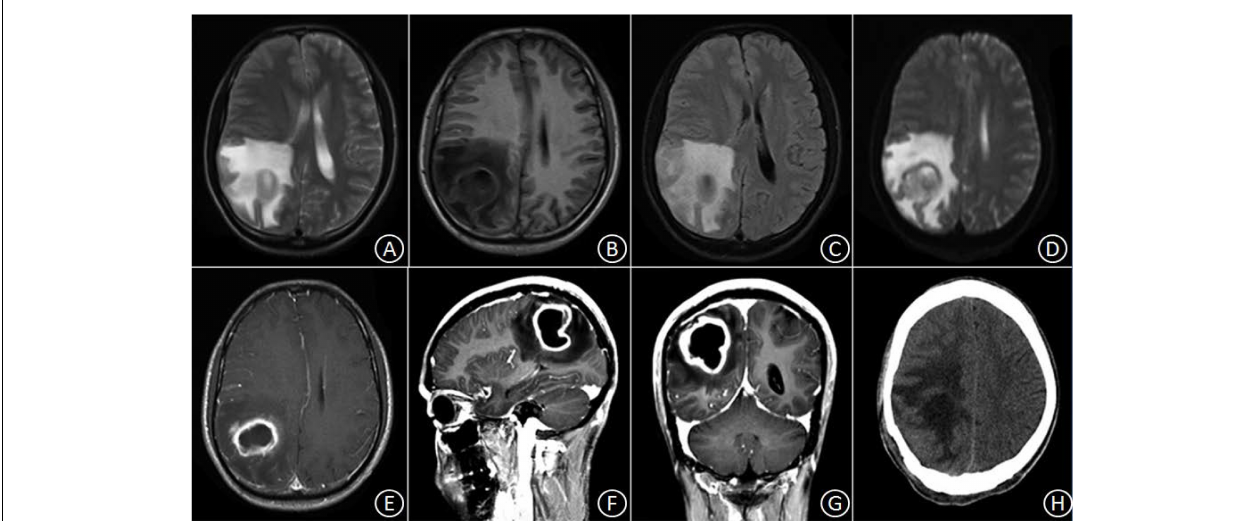
FIGURE 1 | In the right parietal lobe, an irregularly circular space-occupying lesion was found with slightly long T1 and slightly long T2 signal shadows, in which sheet-like, long T1 and T2 signals were observed surrounded by large patches of oedema (A–C) . DWI signals were apparently enhanced, and the marginal ring wall appeared to have a relatively even thickness, which manifested as slightly short T1 and T2 signals (D) . After enhancement, the ring wall exhibited apparent signal intensification (E–G) . Three weeks after the surgery, the space-occupying lesion disappeared, but patches of oedema with blurred boundary remained (H) .